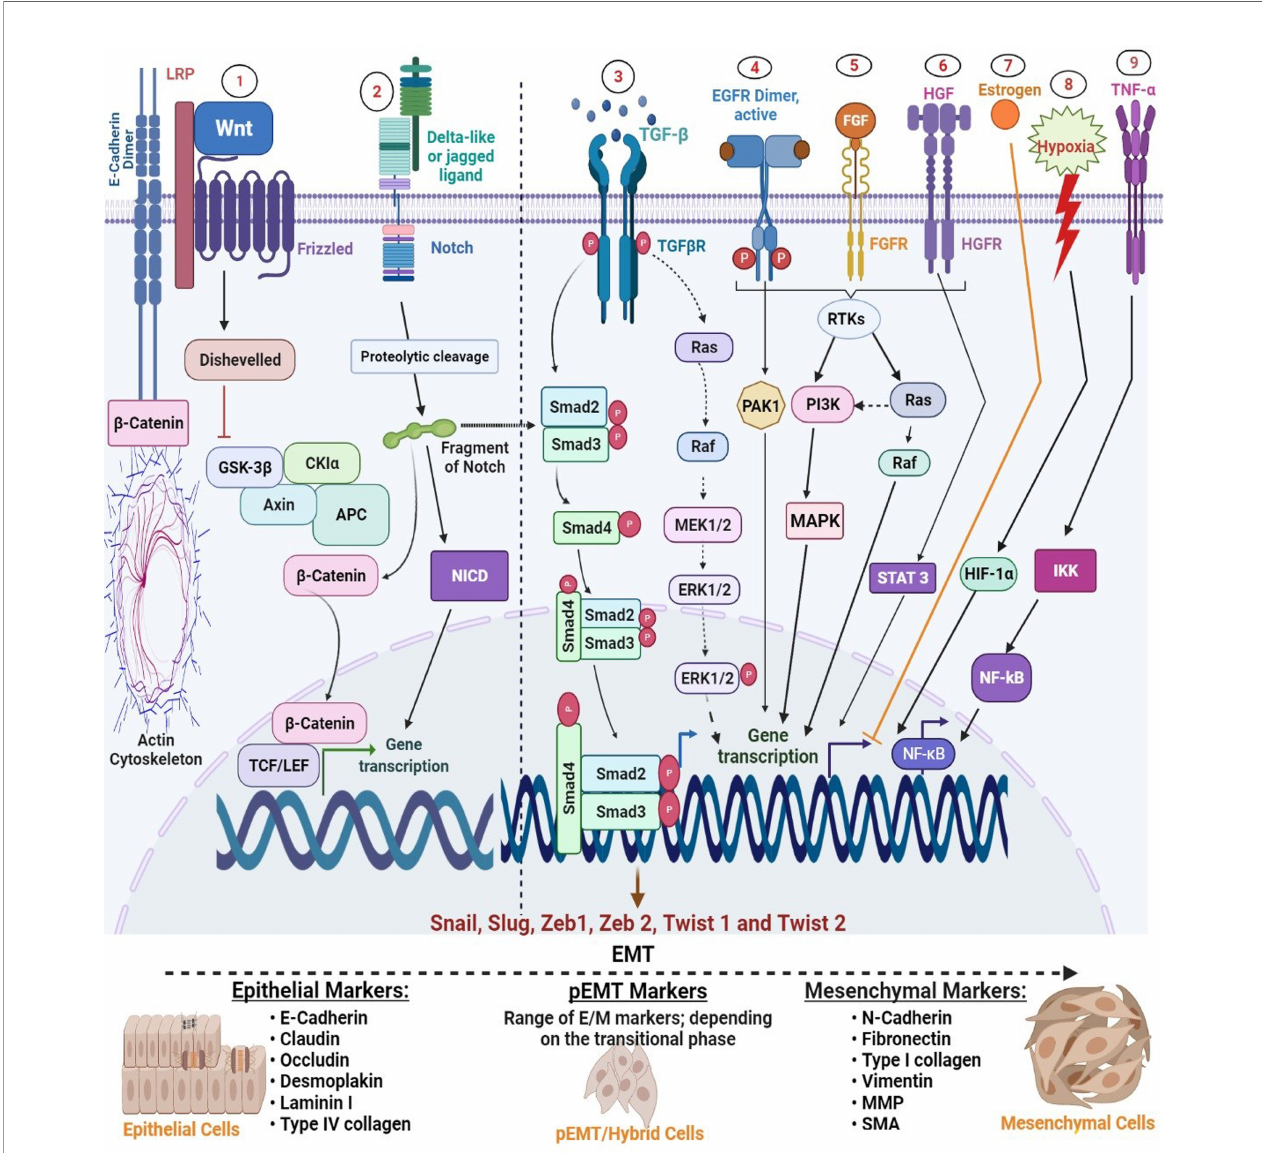
FIGURE 2 | Regulation of major EMT transcription factors by signalling pathways. Epithelial-mesenchymal transition (EMT) is driven by SNAIL, zinc- fi nger E-box- binding (ZEB), and basic helix-loop-helix (bHLH) transcription factors that act as downstream effectors from several other signalling molecules. 1, Wnt signalling: WNT inhibits glycogen synthase kinase-3 b (GSK3 b ) to stabilize b -catenin, which translocates to the nucleus to recruit the transcription factors; lymphoid enhancer-binding factor 1 (LEF) and T-cell factor (TCF) and promotes expression of SNAIL1 and SNAIL2. 2, Notch signalling: binding of a ligand (such as delta-like or jagged) with Notch receptors initiates the Notch signalling through the proteolytic cleavage by g -secretase complex to release NICD. NICD then undergoes nuclear translocation to regulate the expression of target genes, including SNAIL, ZEB, and bHLH families. 3, Transforming growth factor- b (TGF b ) promotes EMT by acting at various strata; SMAD-mediated and non-SMAD signalling (i) SMAD-mediated signalling: Activation of the T b RI and T b RII turns on SMAD2 and SMAD3, which then integrate with SMAD4 to form a trimeric SMAD complex. This complex translocates into the nucleus to stimulate the expression of EMT transcription factors (ii) non-SMAD- mediated signalling: TGF b also activates ERK through the RAS-MAKP pathway. Activated ERK can then stimulate the expression of SNAIL1 and SNAIL2 (unspeci fi ed in the image). 4 – 6, Growth factors (EGF, FGF, and HGF): various growth factors such as EGF, FGF, and PDGF activate receptor tyrosine kinases (RTKs), triggering dimerization and autophosphorylation of the intracellular domain of these receptors, which allows them to activate other downstream signalling molecules, including PI3K, PAK1, and STAT 3 and increase expression of SNAIL1 and SNAIL2. 7, Oestrogen; oestrogen is one of the few molecular candidates that negatively regulate EMT. It does this through direct inhibition of Slug transcription by forming a co-repressor complex consisting of ligand-activated ER a , HDAC1, and nuclear receptor co-repressor (NCoR) that binds to the oestrogen-response elements at the slug promoter sequence and inhibit its expression. 8, Hypoxia: in normoxic conditions, prolyl hydroxylases are activated which causes hydroxylation of HIF-1 a and thereby hindering their activities, whereas, hypoxia stabilizes the enzymes, enabling their nuclear translocation and heterodimerization and binding to oversee stimulation of Twist and stabilization of SNAIL1/2. 9, Tumour necrotic factor-alpha (TNF- a ): TNF- a signal activates IKB kinase complex (IKK), which in turn phosphorylates NF-kB inhibitor. Consequently, NF-kB becomes active and undergoes nuclear translocation to promote induction of Twist1 expression.